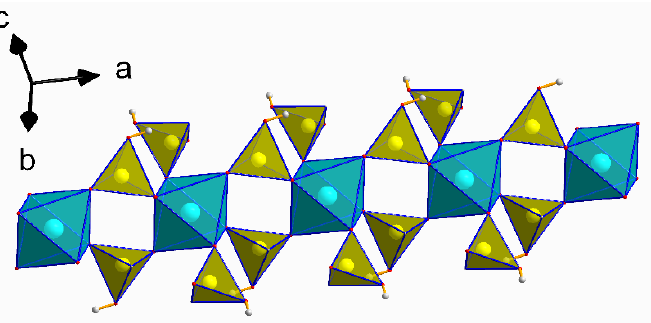
Figure 2. A fragment of the structure of (H 2 DAB)[Co(H 2 PO 3 ) 4 ] · 2H 2 O along [010], showing the infi- nite four-membered ring chain propagating along [100]. Polyhedrons: cyan [CoO6], yellow H 2 PO 3 − . Table 2. Hydrogen bonding network in the framework of (H 2 DAB)[Co(H 2 PO 3 ) 4 ] · 2H 2